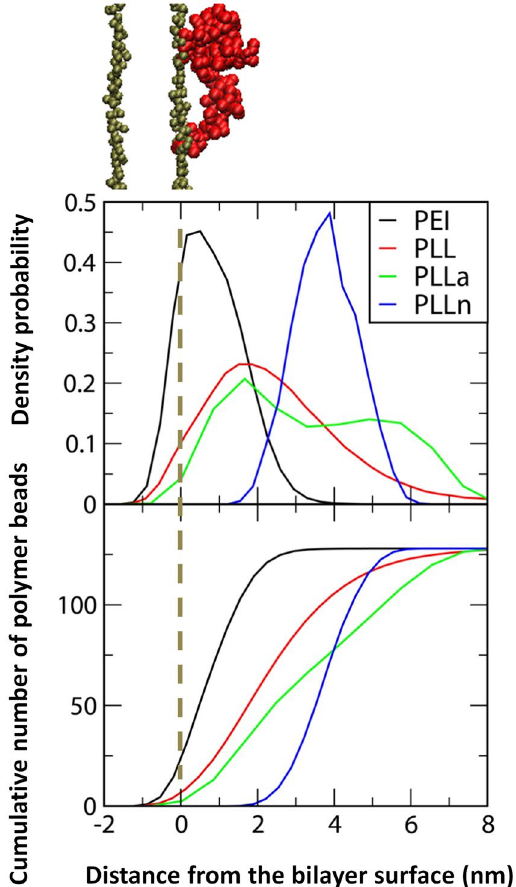
Figure 6. Density probabilities of polymer chains on the bilayer surface as a function of distance from the z-directional center of mass of lipid-phosphate beads in the adjacent leaflet (top) and the cumulative numbers of charged (or neutrally mutated) beads